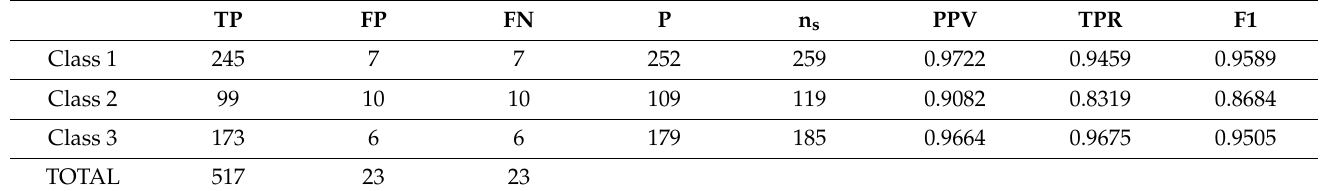
Table 1. Metrics for quantitative indicators from the two-fold cross-validation.